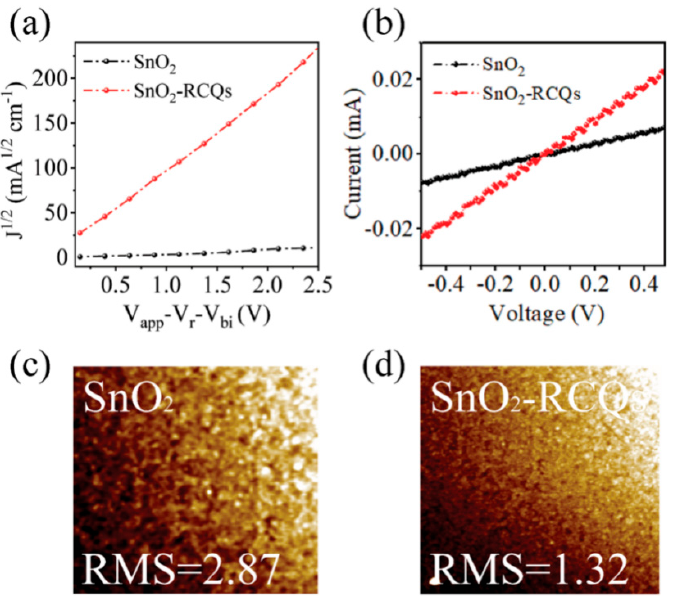
Figure 9. ( a ) J–V characteristics of the electron-only devices based on the SnO 2 -RCQs and SnO 2 electron transport layers (ETLs), from which their electron mobility was calculated from the SCLC model. ( b ) Conduction properties of the SnO 2 films with and without red-carbon quantum dots (RCQs). ( c , d ) AFM height images of the SnO 2 and SnO 2 -RCQs films, respectively. Copyright Reproduced with permission from Ref. [92].